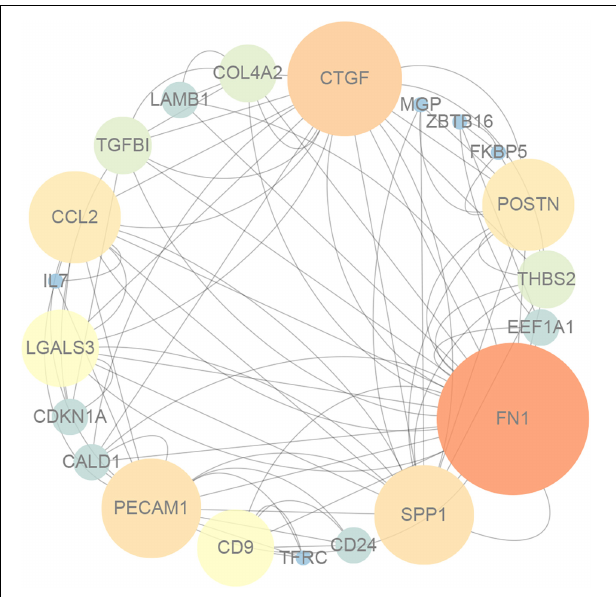
FIGURE 3 | The protein–protein interaction network for DEGs, and the nodes with lighter color and bigger size represent the hub genes.